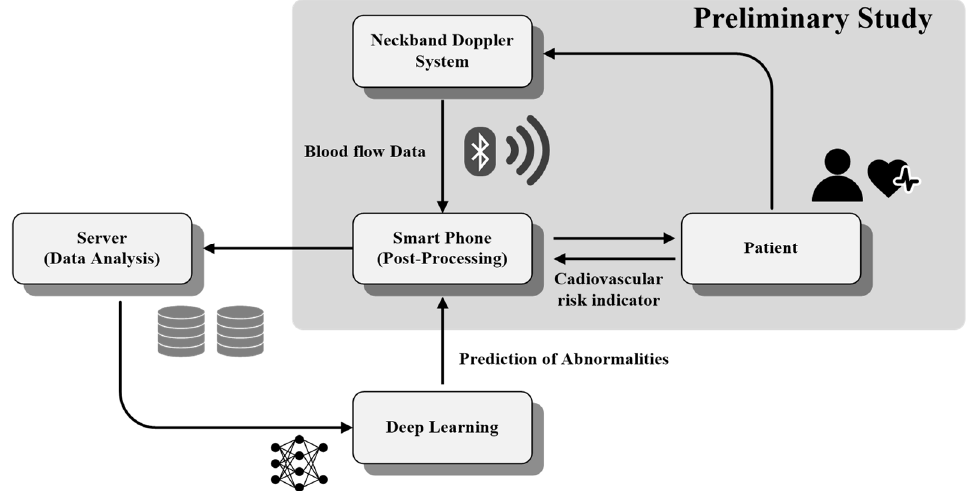
Figure 10. Prediction model of cerebrovascular and / or cardiovascular diseases by using the wireless carotid neckband ultrasound Doppler system and Deep Learning.